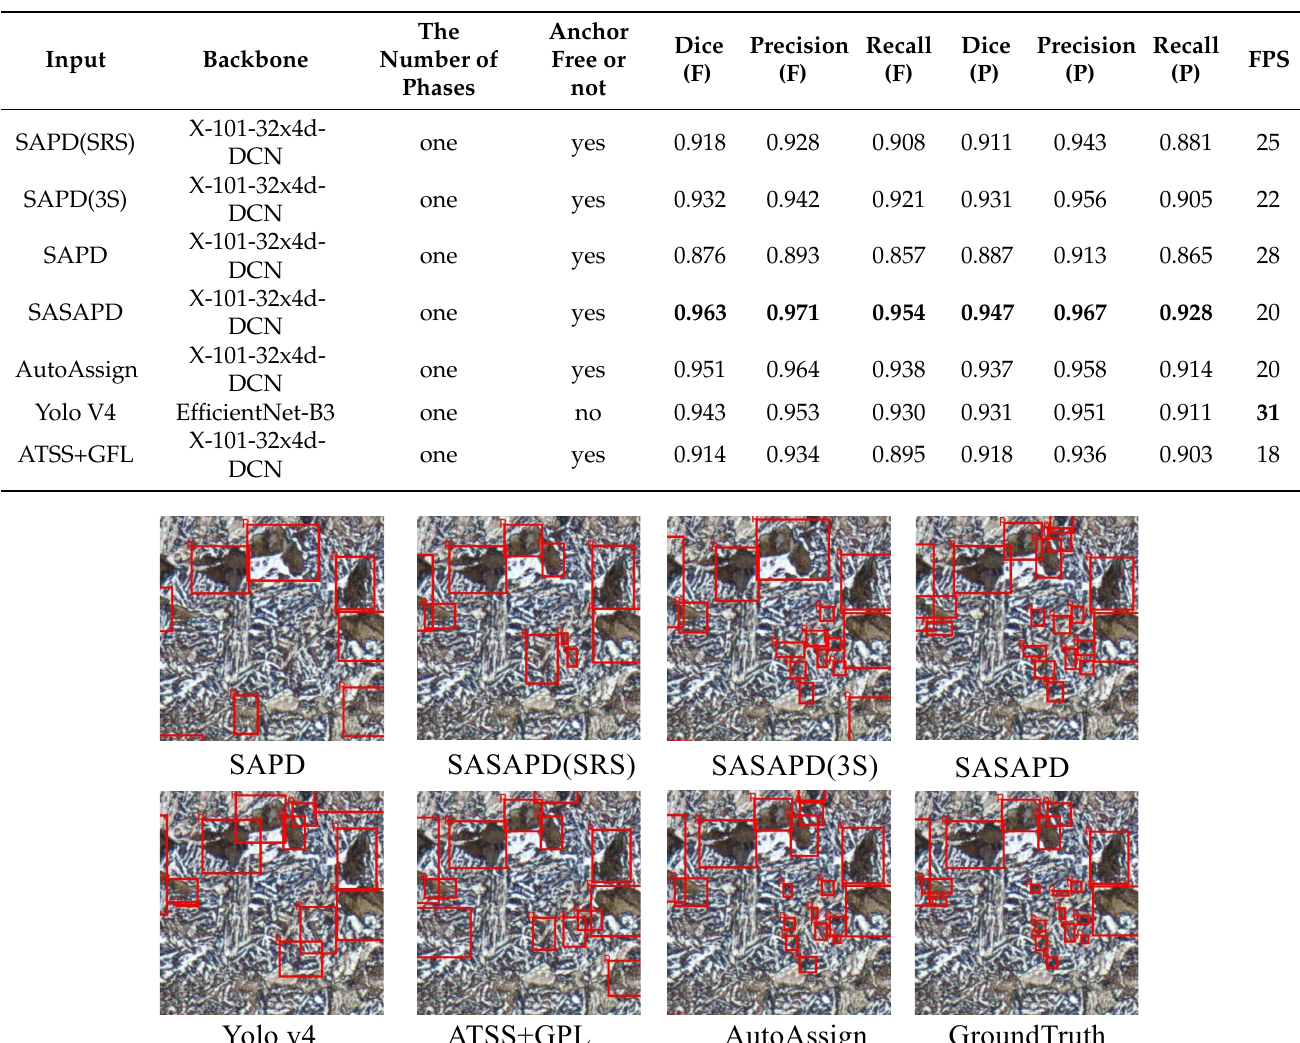
Table 5. The quantitative comparison of identifying the elements of ferrite (F) and pearlite (P) on dataset MPMID. The best results are highlighted in bold.